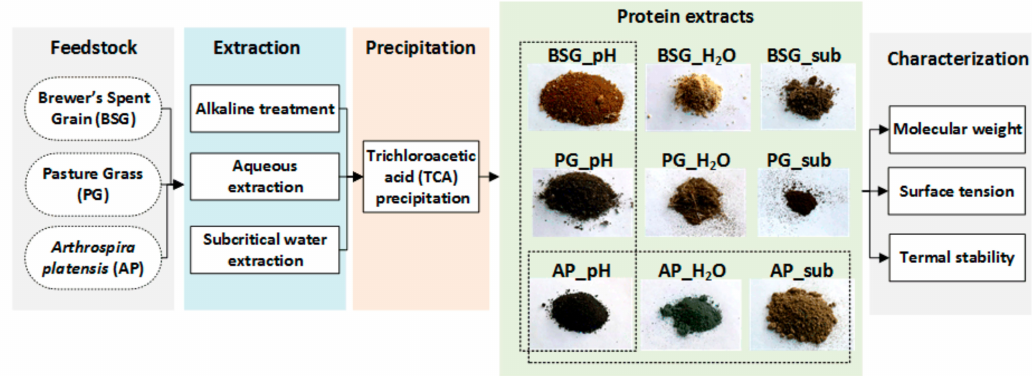
Figure 5. Scheme of the experimental process for protein extraction by three di ff erent methods (alkaline treatment, aqueous extraction, and subcritical water extraction) of three types of biomass (brewer’s spent grains (BSG), pasture grass (PG), and Arthrospira platensis